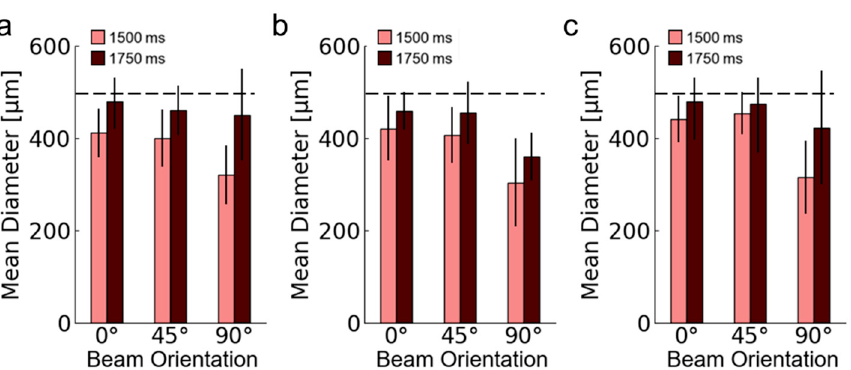
Figure 15. Measured mean beam diameters for 1500 ms and 1750 ms exposure per layer with standard deviation bars for designs of ( a ) BCC-0.5 ρ r , ( b ) BCC-0.4 ρ r , and ( c ) BCC-0.3 ρ r . Dotted lines provide references for the 500 µm intended beam diameter for each design.